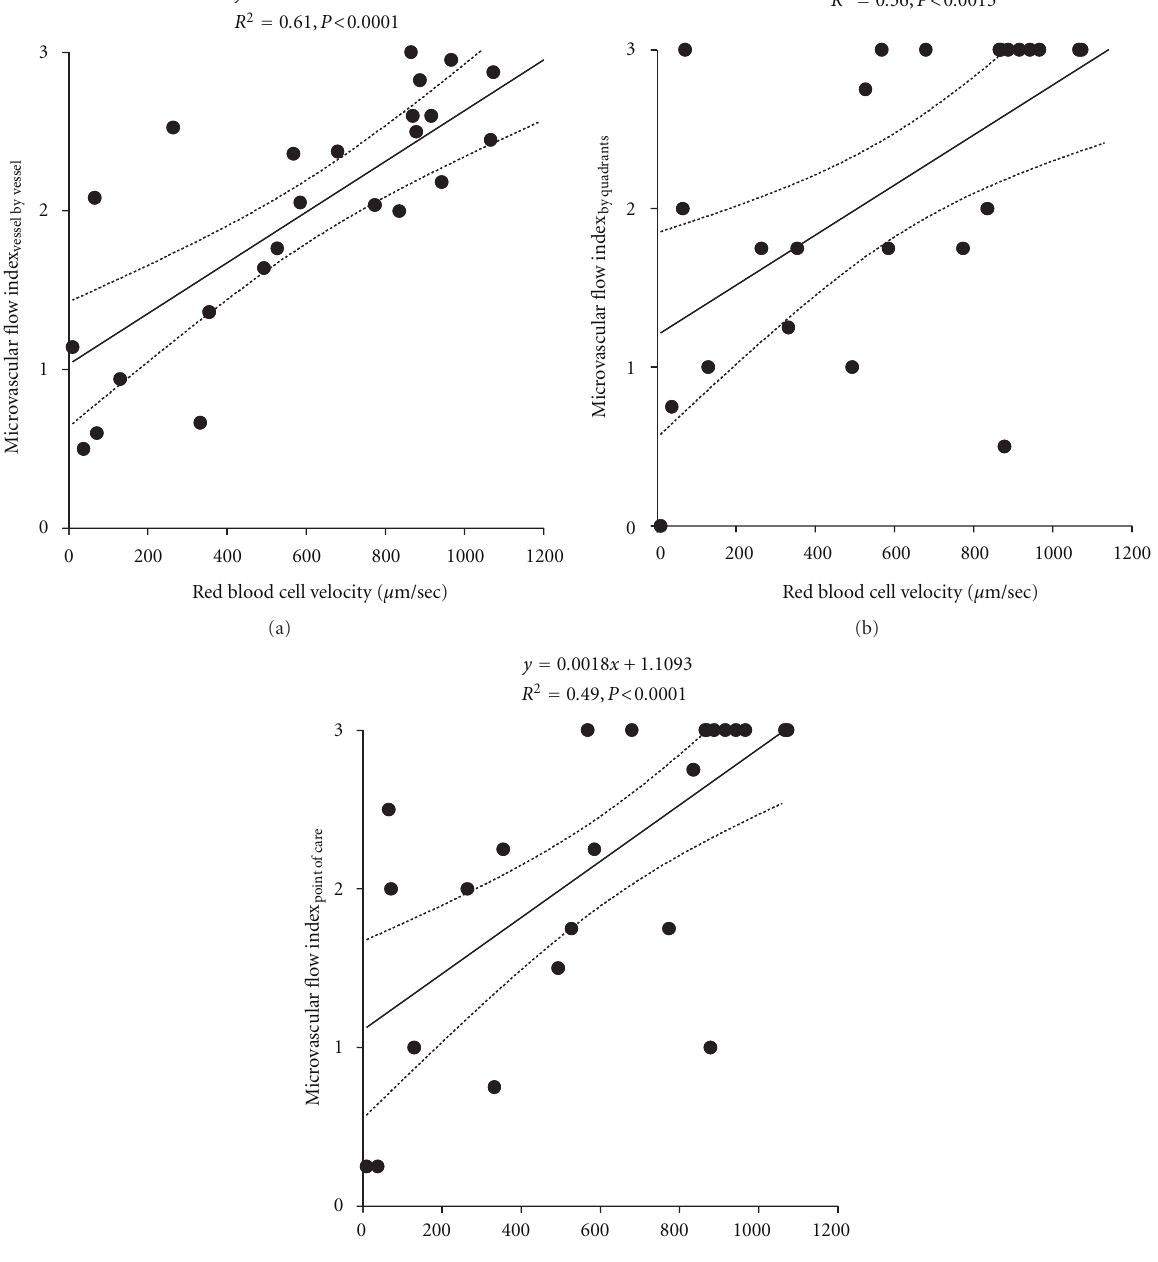
Figure 2: Correlations of the red blood cell velocity with the microvascular flow index determined by vessel by vessel analysis (MFI vesselbyvessel ) Panel (a), the microvascular flow index determined by quadrants (MFI byquadrants ) Panel (b), and the bedside point-of-care microvascular flow index (MFI pointofcare ) Panel